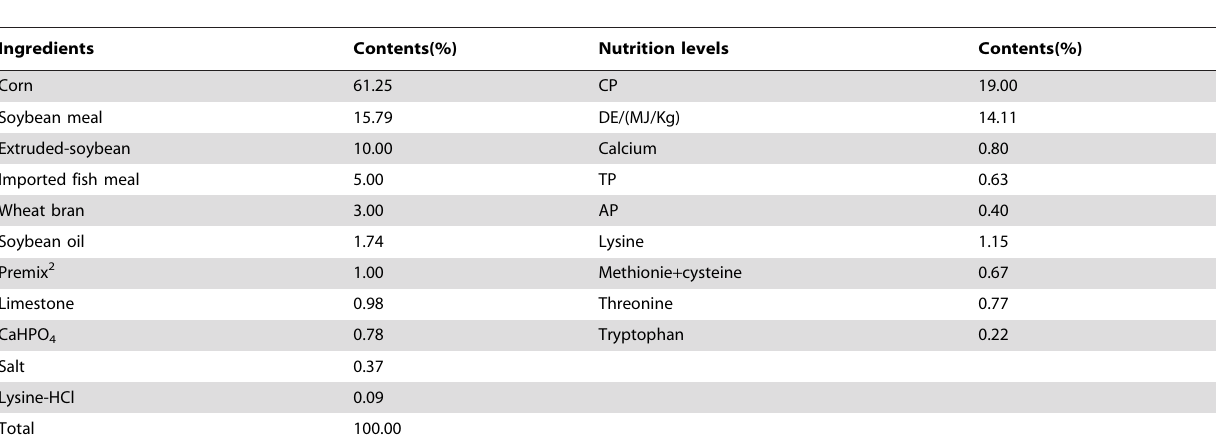
Table 2. Composition and nutrient levels of basal diet (as-fed basis) 1